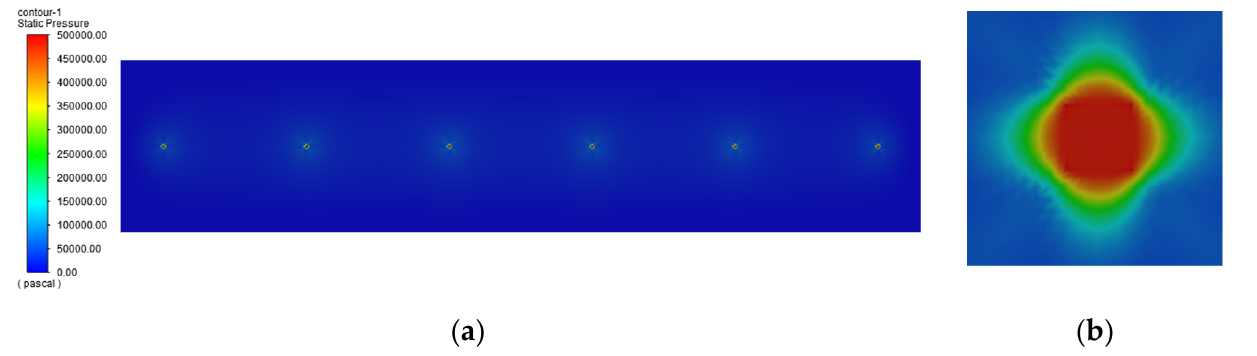
( b ) Figure 7. ( a ) Pressure distribution on a balance d surface of an air film (0.5 MPa). ( b ) Pressure distri- bution near the throttle hole. Nevertheless, when the air film structure is asymmetrical, the pressure distribution changes compared with the scenario elaborated above. At this time, there are five throttle holes fully covered and one throttle hole half covered by the slider block, as shown in Figure 8a. For this case, the pressure distribution around the half-covered hole is plotted in Figure 8b. In this position, the air cavity is the inlet to input the compressed air and the area of throttle hole not covered by the slider serves as the outlet. The air pressure at the half-covered throttle orifice is slightly lower compared with the others, and a semi-ring- shaped, low-pressure area is formed near the half-covered throttle hole in the air film. Moreover, Figure 8c shows the pressure distribution near the fully covered throttle orifice hole in the unbalanced condition. The pressure is highest at the throttle hole; meanwhile,